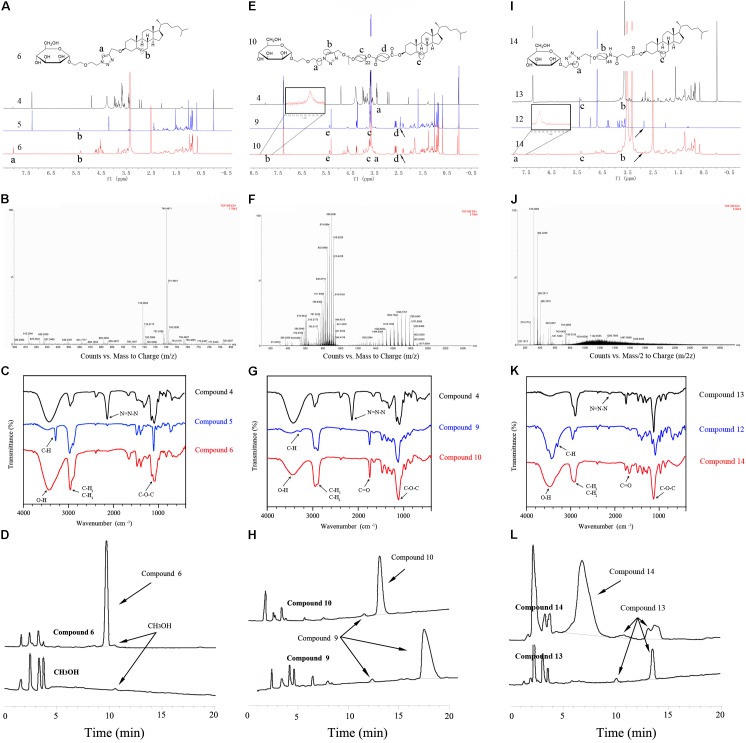
Characterization of MPn-CHs. (A) Comparison of the 1H NMR spectra of compounds 4, 5, and 6. The protons of olefinic bond (N-CH = C-N) in coupled places were shown in compounds 6. (B) Mass spectrum of MP100-CH was shown as (M + Na)+, m/z: 740.4911. (C) FTIR spectrum of compounds 4, 5, and 6. (D) High purity (97.984%) of MP100-CH was confirmed using HPLC. (E) Comparison of the 1H NMR spectra of compounds 4, 9, and 10 in CDCl3. (F) Mass spectrum of compounds 10 was shown as (M+Na)+, m/z: 1484.8359 to 1830.8468. (G) FTIR spectrum of compounds 4, 9, and 10. (H) HPLC spectra was used to evaluate the purity of MP1000-CH (95.621%). 1H NMR spectra (I) and FTIR spectrum (K) of compounds 12, 13, and 14. (J) Mass spectrum of MP2000-CH was shown as (M/2+Na)+, m/z. (L) The purity of MP2000-CH was evaluated (91.532%).